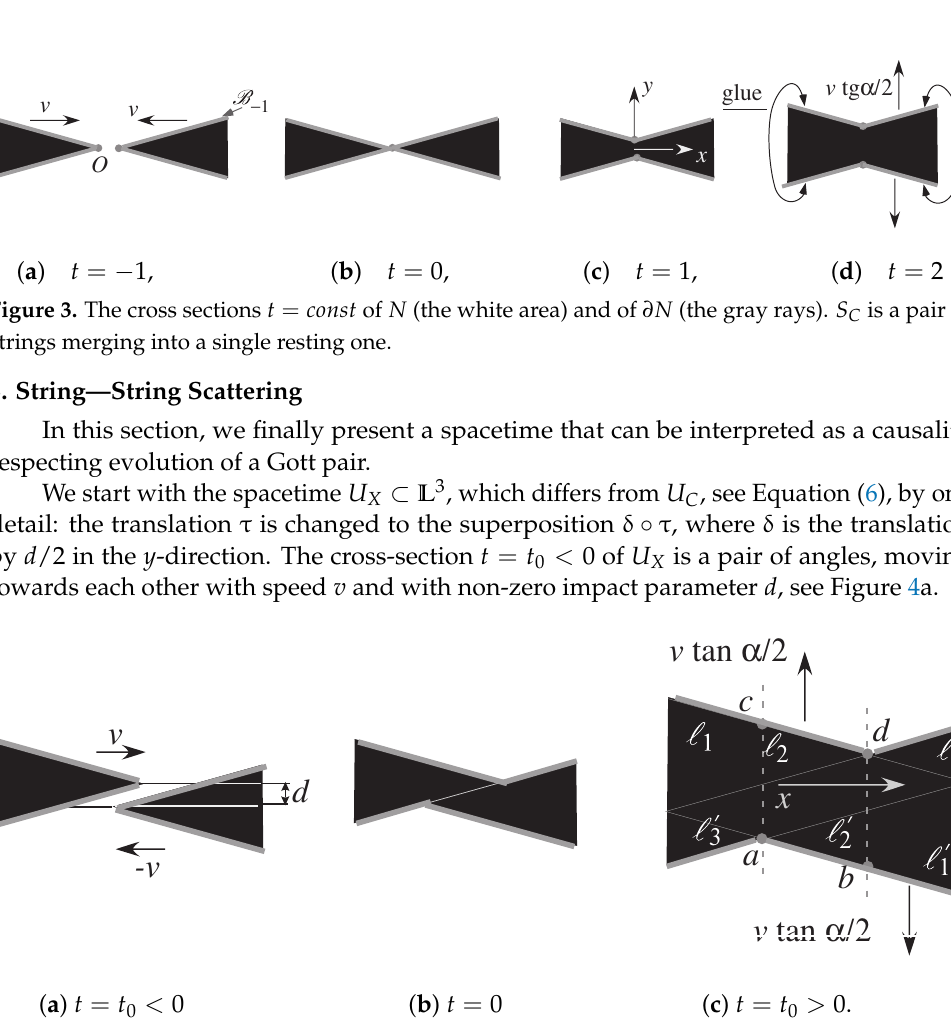
Figure 4. The gray lines are the sides of corresponding